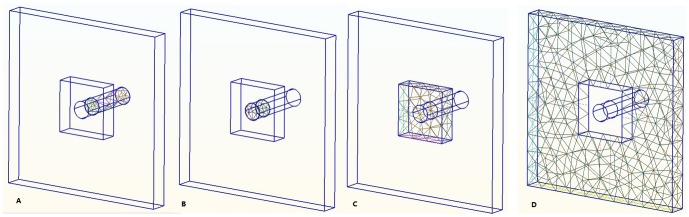
Four partitions of FEM.(a) Static. (b) Dynamic.